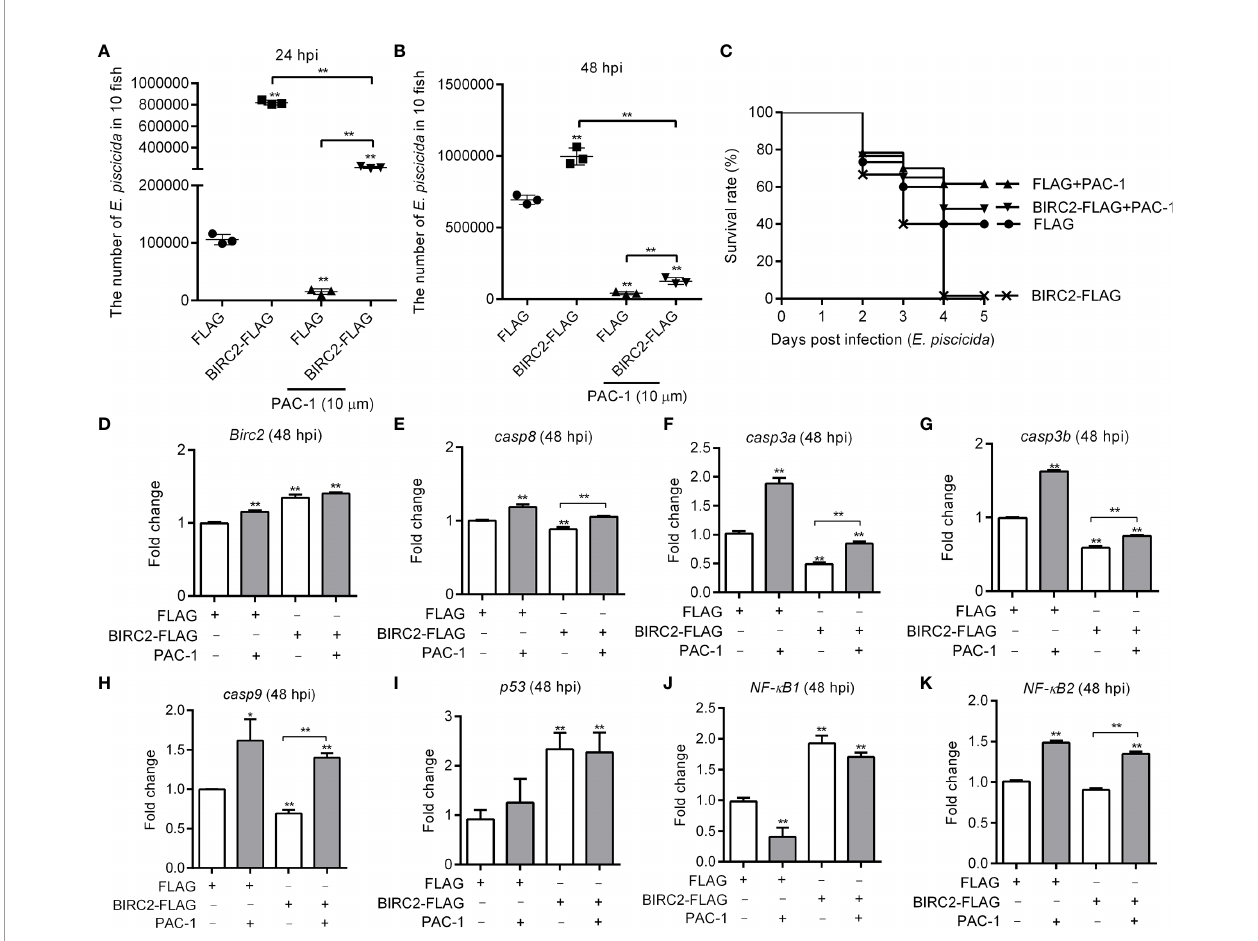
FIGURE 5 | The caspase activator PAC-1 blocks the negative regulation of zebra fi sh BIRC2 on the E. piscicida infection. (A) PAC-1 inhibited the zebra fi sh BIRC2- mediated bacterial proliferation at 24 hpi. (B) PAC-1 blocked the zebra fi sh BIRC2-mediated bacterial proliferation at 48 hpi. For (A, B) , larvae were collected at 24 and 48 hpi, and used for colony count. Data represented the means ± the SEM (n = 3) and were tested for statistical signi fi cance using a two-tailed student ’ s t -test. ** p < 0.01. The asterisk above the error bars indicates statistical signi fi cance using the group microinjected with empty plasmid and without treatment as the control group. The asterisk above the bracket indicates statistical signi fi cance between the two groups connected by the bracket. (C) The effect of PAC-1 on the survival rates of zebra fi sh larvae microinjected with p3×FLAG or BIRC2-FLAG in the case of E. piscicida infection. Exposures were performed in triplicate with 20 larvae per repetition (n = 60). Statistical differences using the log-rank test were observed between the FLAG/BIRC2-FLAG groups ( p < 0.0001), FLAG/FLAG+PAC-1 groups ( p < 0.05), and BIRC2-FLAG/BIRC2-FLAG+PAC-1 groups ( p < 0.0001). (D – K) The effect of PAC-1 on the expression levels of apoptosis-related genes and NF- k B genes in zebra fi sh larvae microinjected with p3×FLAG or BIRC2-FLAG at 48 hpi. For (D – K) , larvae were collected at 48 hpi, and used for qRT-PCR. Data represented the means ± the SEM (n = 3) and were tested for statistical signi fi cance. * p < 0.05; ** p < 0.01. For (A – K) , 4 dpf larvae microinjected with the p3×FLAG or BIRC2-FLAG were treated by adding PAC-1 for 12 h, and then infected with E . piscicida